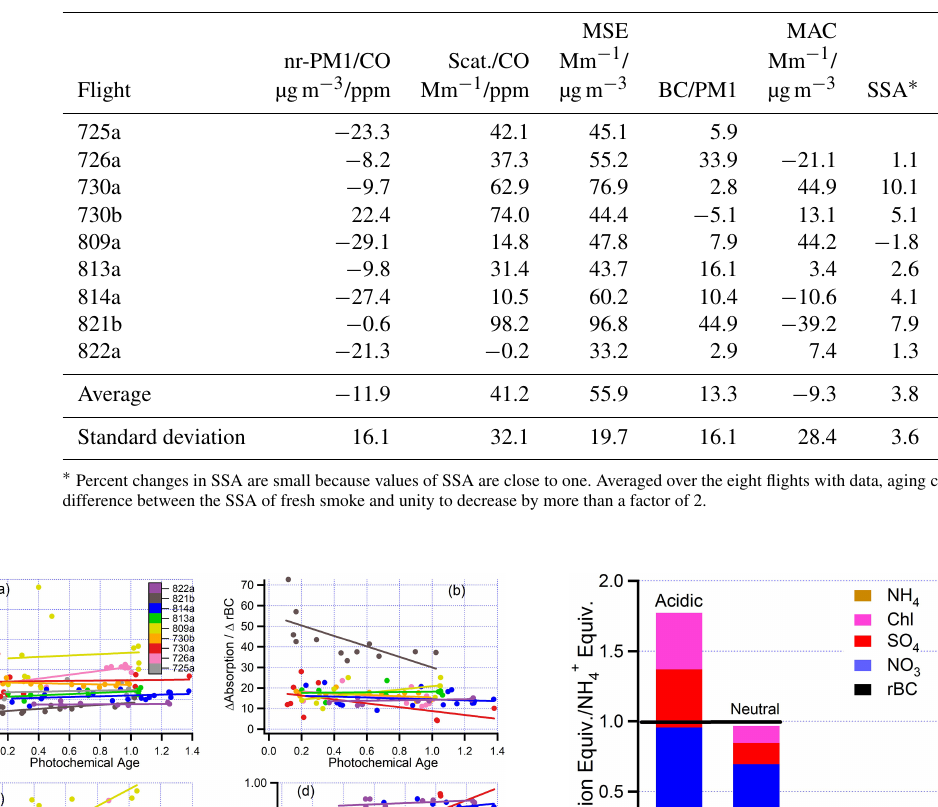
Table 6. Percent change, 100 (X Aged -X Fresh )/X Fresh , between aged and fresh emissions.